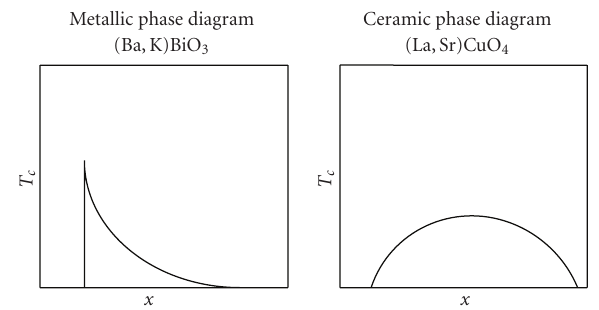
Figure 1: There are large qualitative di ff erences between the phase diagrams of layered ceramic cuprates, such as La 2 − x Sr x CuO 4 , and cubic Ba 1 − x K x BiO 3 . The former requires a percolative model, but the superconductive properties of the latter can be explained using a traditional BCS continuum